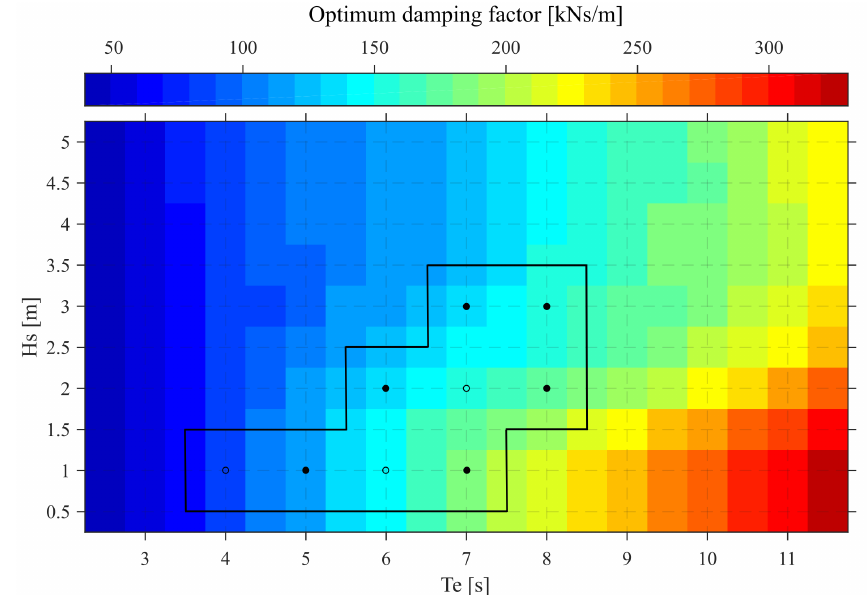
Figure 4. Each combination of H s and T e is characterized by an optimum damping factor that maximizes the WEC energy absorption. The area enclosed in the black polygon corresponds to the area of the wave climate scatter plot containing the most recurrent